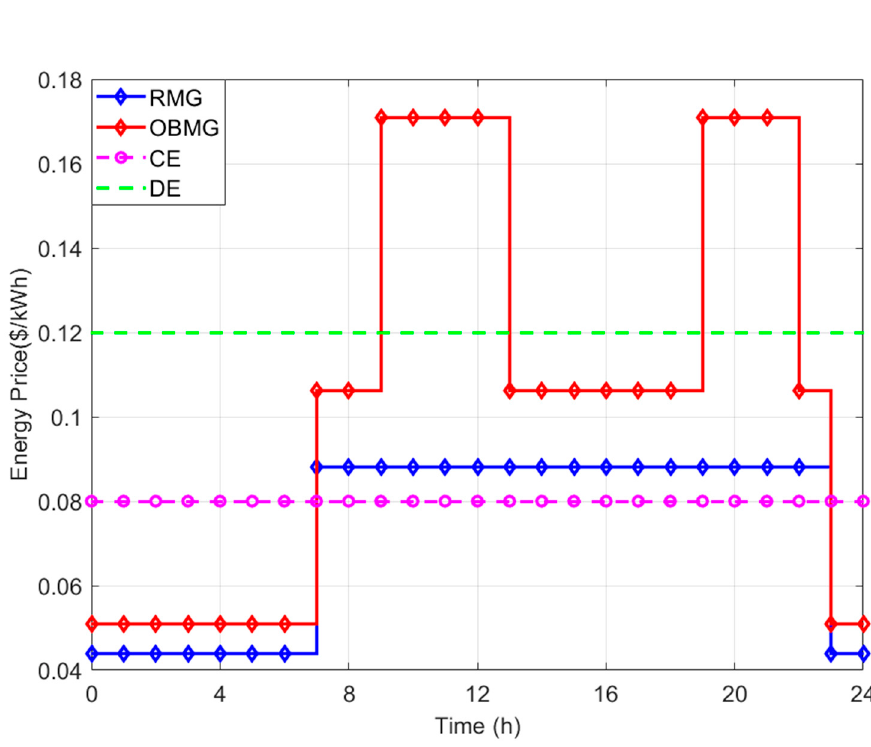
Figure 5. Prices of energy exchanging and EV charging and discharging.